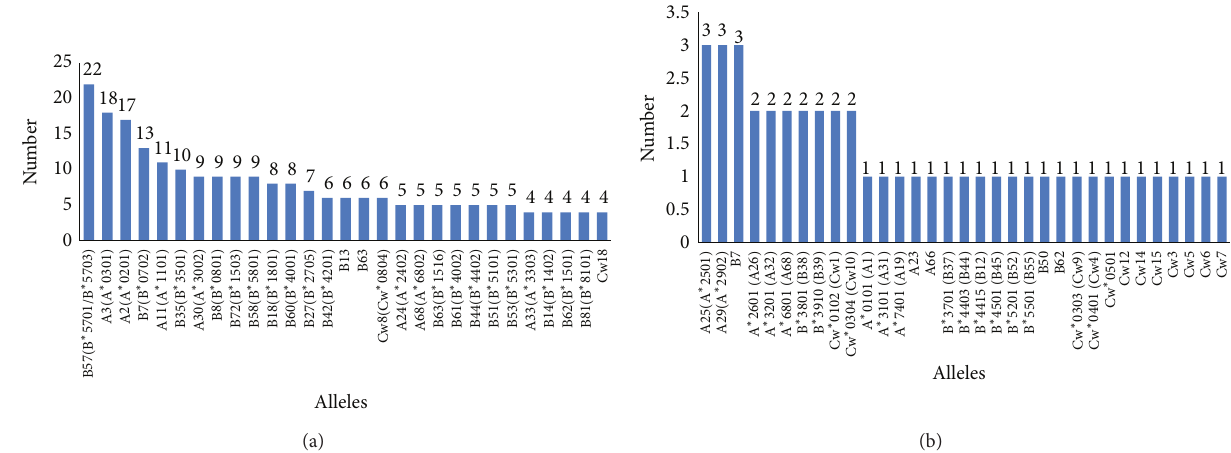
Figure 5: The number of unique alleles recognized by the optimal CTL epitopes.